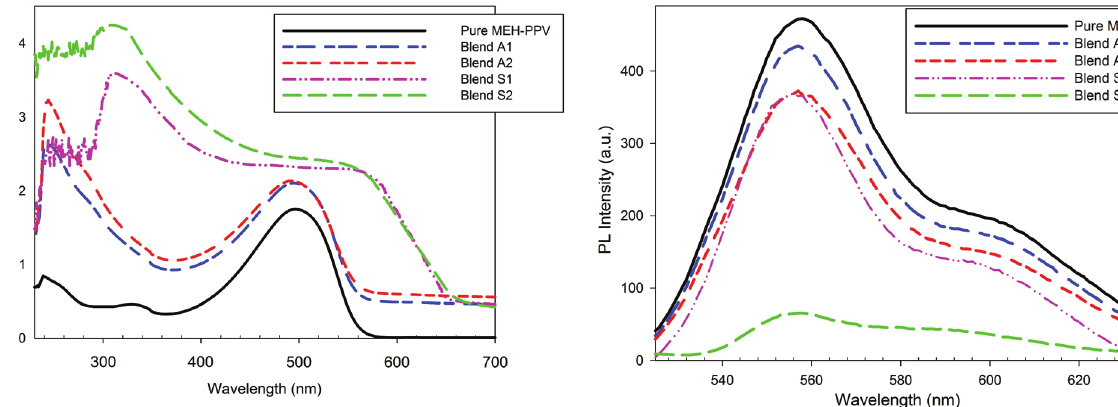
Figure 11 UV-vis of pure MEH-PPV and BHJSC active layer blends A1, A2, S1, and S2.